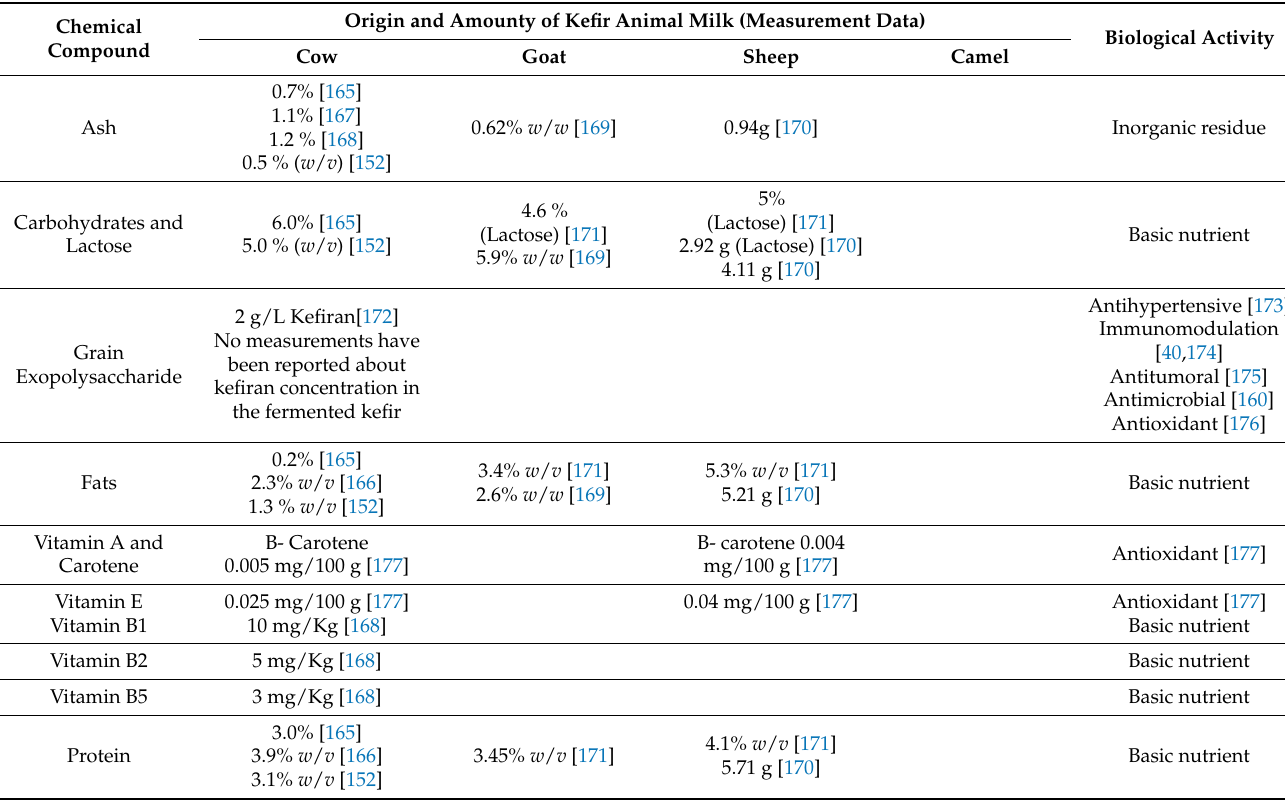
Origin and Amounty of Kefir Animal Milk (Measurement Data)